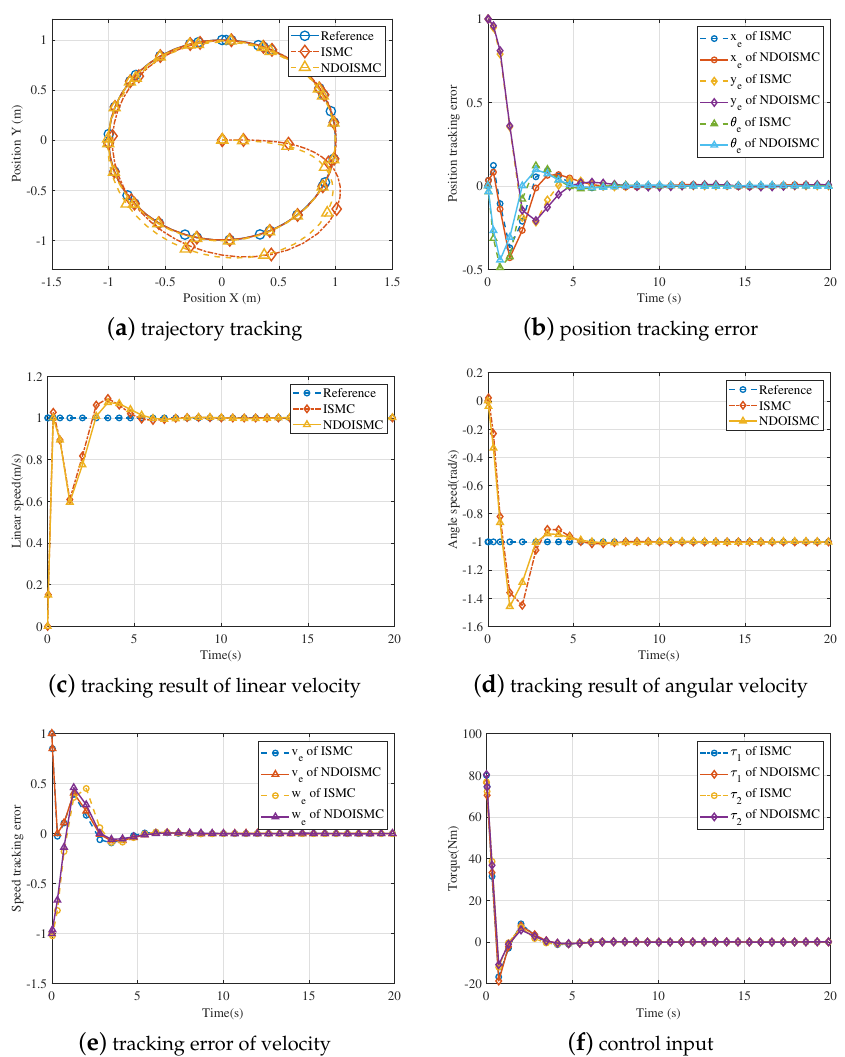
Figure 4. Comparative simulation results for circular trajectory